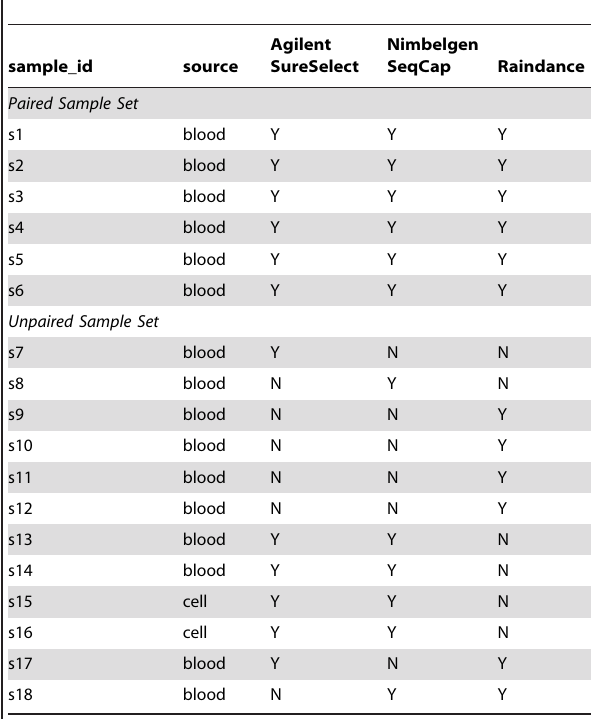
Table 1. Enrichment methods performed for each